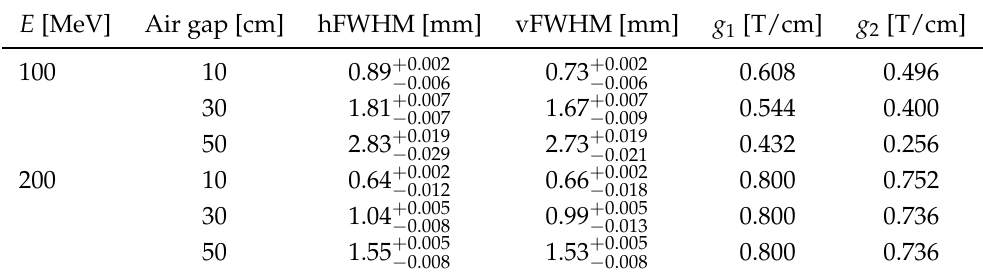
Table 2. Results of the minimisation simulations stating the horizontal and vertical beam size (hFWHM and vFWHM) as well as the corresponding quadrupole field gradients ( g 1 and g 2 ). The fo- cussing plane configuration was the same in all cases with Q1 (Q2) focussing vertically (horizontally). Top: Results for the base beam model considering three different air gap lengths. Bottom: Results for the different beam model variations considering only the 10 cm air